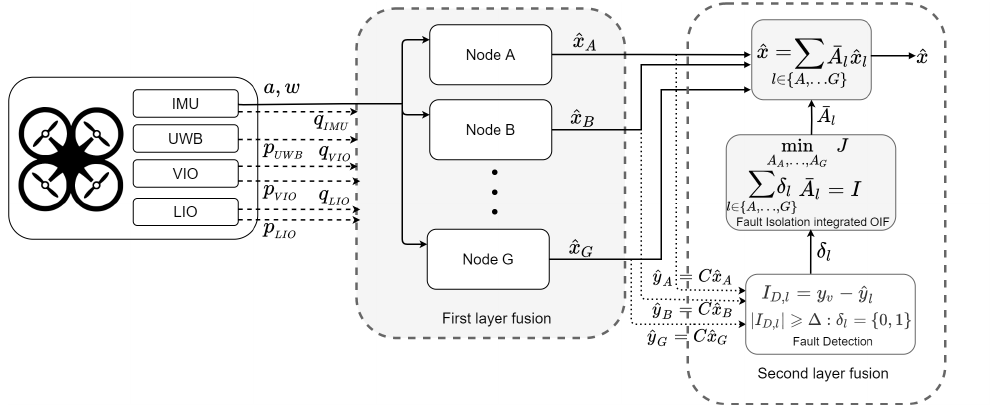
Figure 3. The Fault resilient optimal information filter with a two-layered fusion arrangement. An emphasized description of the first layer fusion is given in Figure 4.